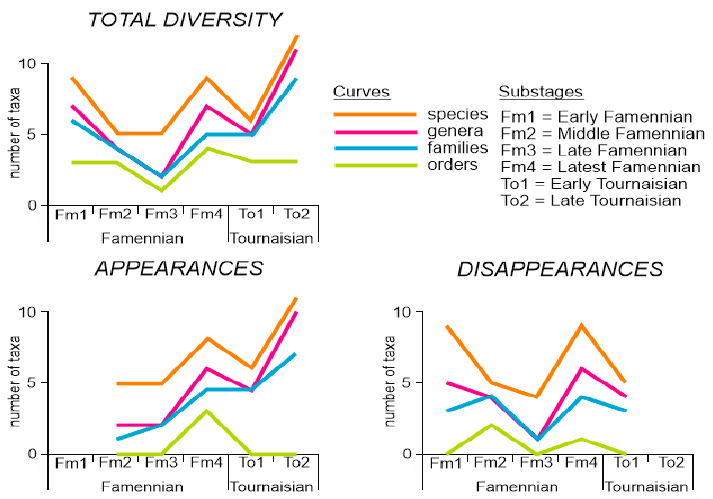
Figure 3. Principal patterns of the taxonomic diversity dynamics of the studied bryozoans (created by the authors, see Table 1 for numbers). Table 2. R and RST indices for the studied bryozoan